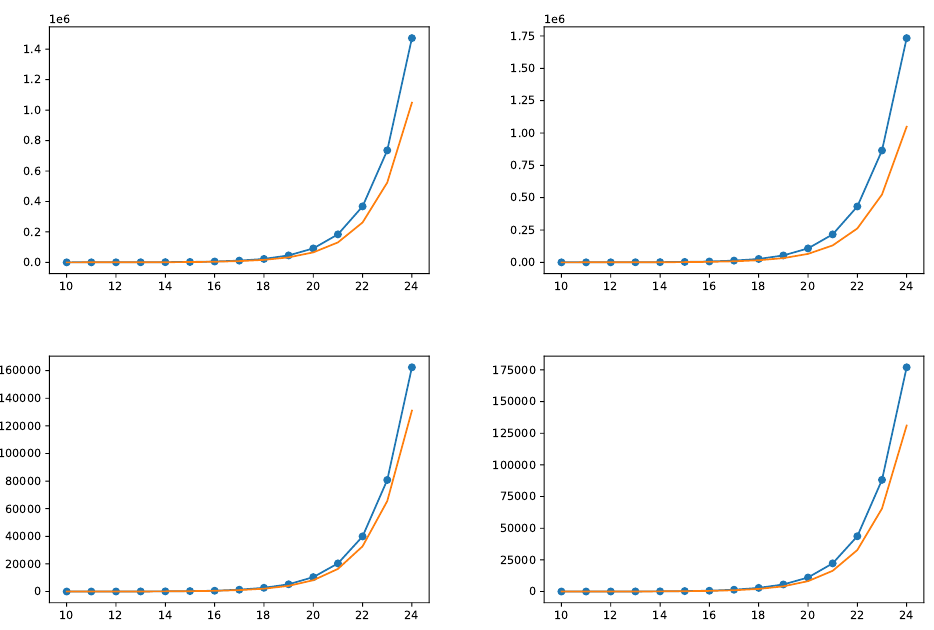
Figure 29. The amount N of numbers proven by applying the five rules from points x to 2 n x is plotted here against n. Function 2 n is shown in orange as a reference. Clockwise from the upper left, the starting points are 31, 161, 13121, and 511. [42].